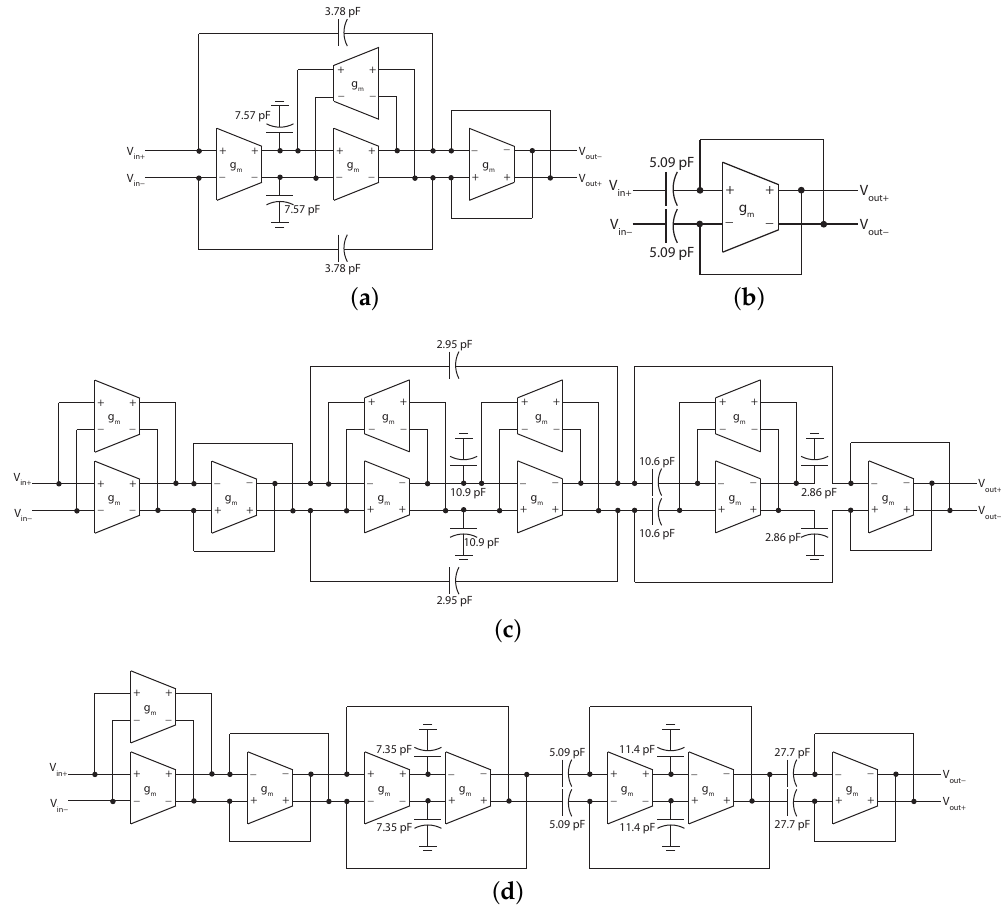
Figure 7. g m C circuit topologies realising the ADWT. ( a ) ADWT1 approximation low pass filter; ( b ) ADWT1 details high pass filter; ( c ) ADWT4 approximation low pass filter; ( d ) ADWT4 details high pass filter. All transconductors are the same (Figure 8) with value 12.5